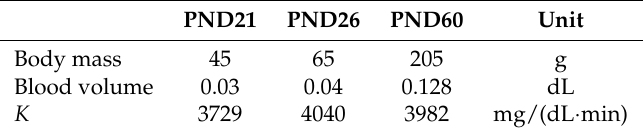
Figure 2. Approximation of the plasma glucose rate of appearance in 21-day-old rats (PND21). Table 2. Values of body mass, blood volume, and parameter K at PND21, -26 and